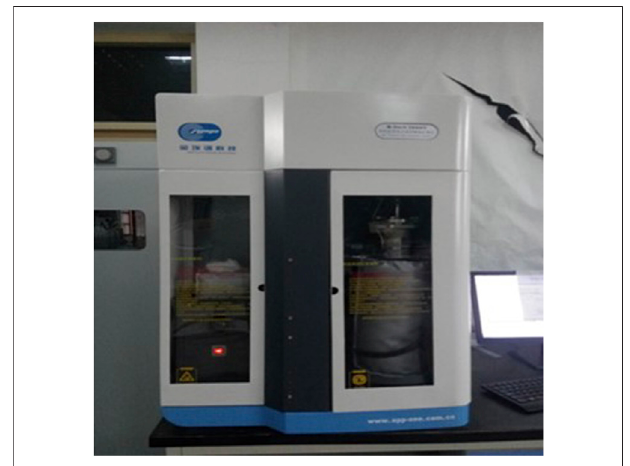
FIGURE 1 | Hsorb-2600 high-temperature and high-pressure gas adsorbent